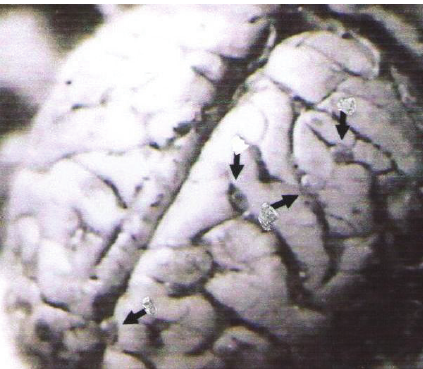
Figure 2: Photograph of the brain of a monkey given 12,000 eggs showing multiple cysts in the subarachnoid space.